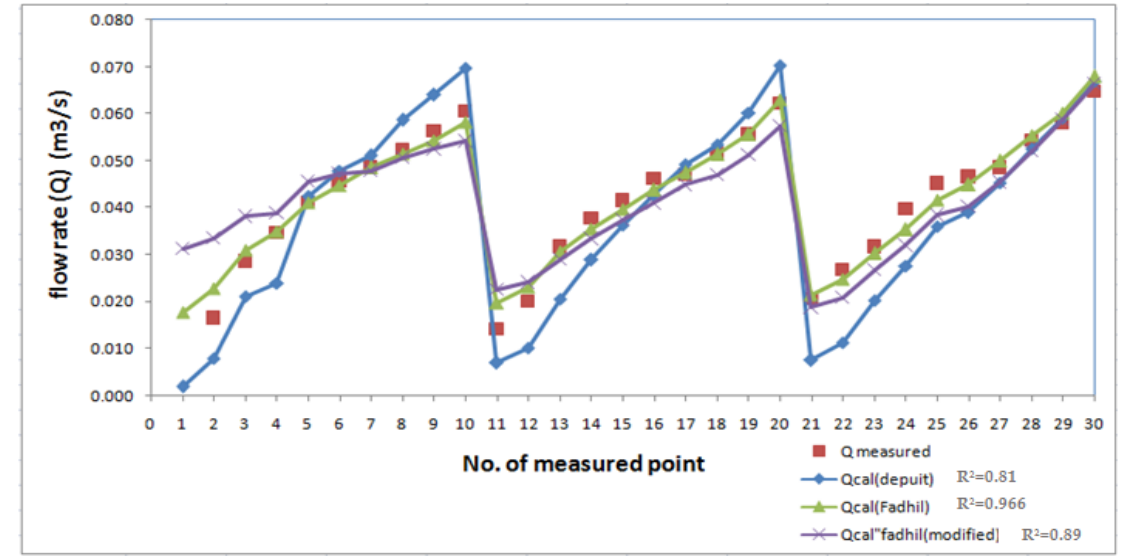
Figure 6. Comparison between the flow rate obtained by the empirical equations of Dupuit, Fadhil, and modified Fadhil and the experimental results.